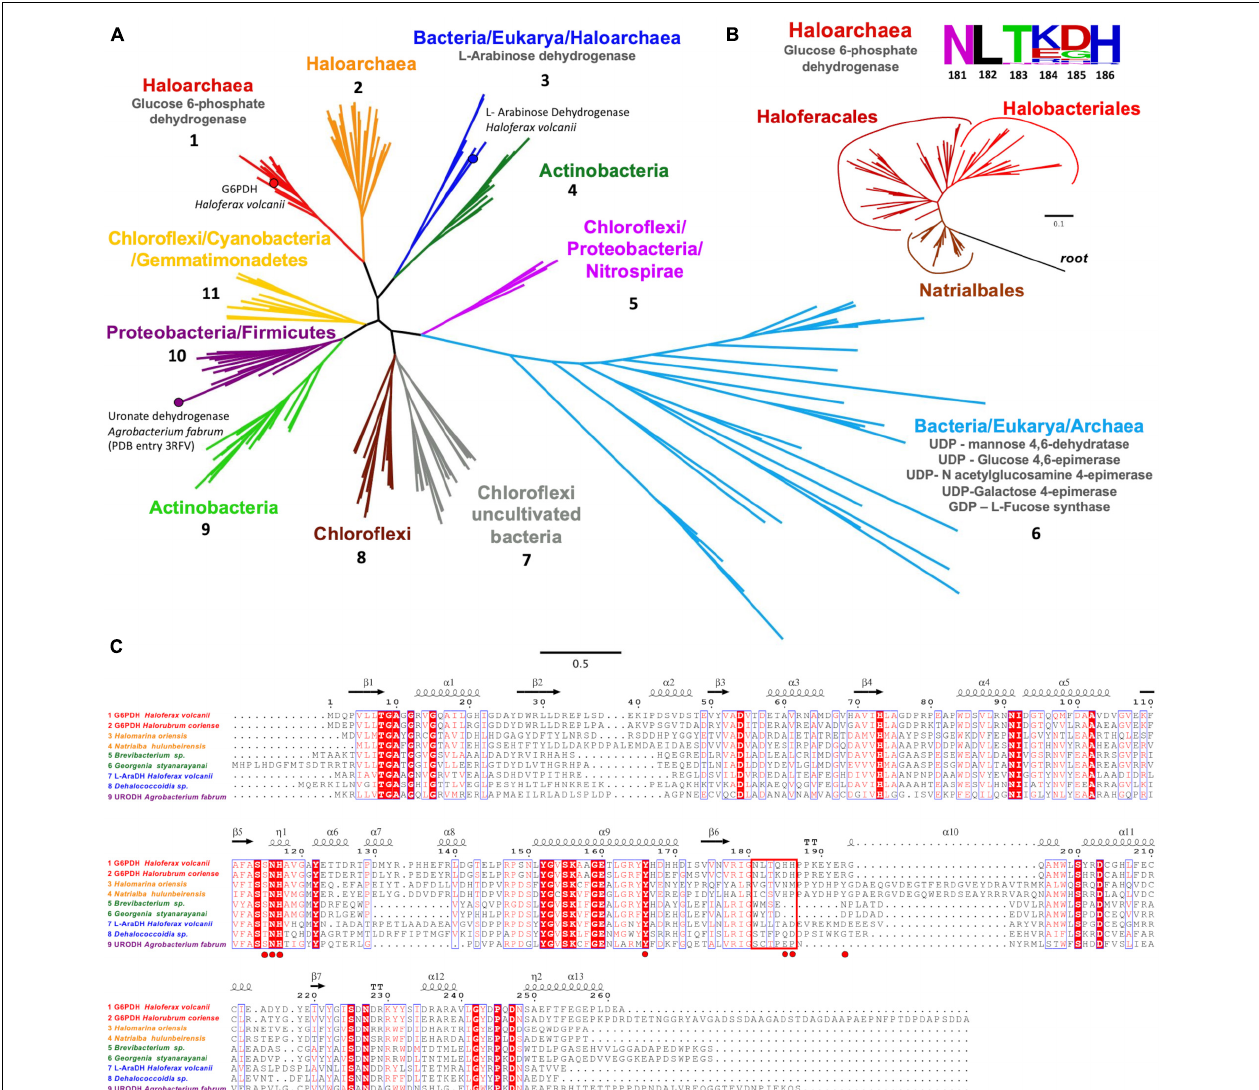
FIGURE 7 | Phylogenetic relationship and sequence analysis of Hv G6PDH. (A) Monophyletic branches (numbered from 1 to 11) with their respective functions are represented in different colors. (B) Phylogenetic tree of glucose 6-phosphate dehydrogenase from Halobacteria showing the segregating branches of Natrialbales , Halobacteriales , and Haloferacales . Sequences from the short-chain dehydrogenases/reductases (SDR) superfamily were used as the outgroup. The sequence logo for the β 6- α 10 loop motif is also shown. (C) Sequence alignment of representative enzymes from groups one to four and the uronate dehydrogenase from Agrobacterium fabrum . The red rectangle indicates the β 6- α 10 loop motif. The G6P interacting residues for Hv G6PDH are highlighted in red circles. The protein sequence codes used in the phylogenetic inference are listed in Supplementary Table 3